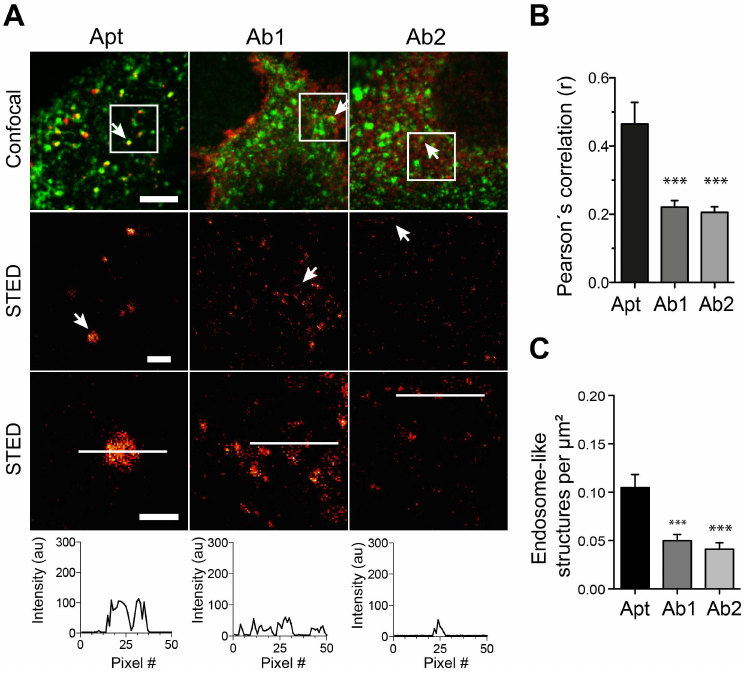
Fig 7. Recognition of subcellular structuresusing STED microscopy in aptameror antibody stained samples against ErbB2. Figure legendis equivalent to legendon Fig 6, but for ErbB2.